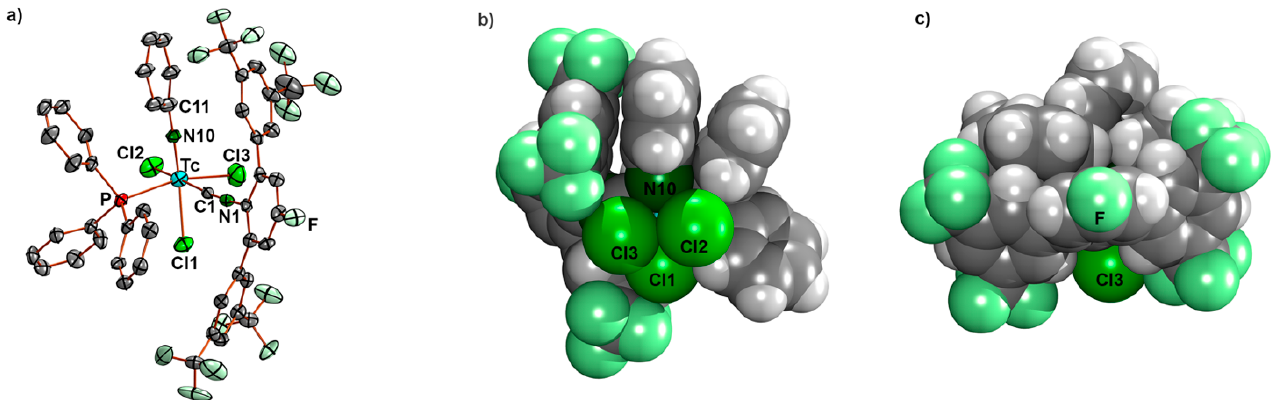
Figure 3. ( a ) Ellipsoid representation of the molecular structure of [Tc(NPh)Cl 3 (PPh 3 )(CN p -FAr DarF2 )] ( 5 ) and illustration of the steric bulk caused by the isocyanide and PPh 3 ligands by ( b ) A view along the phenylimido plane and ( c ) A view along the isocyanide bond. Selected bond lengths and angles: Tc-N10 1.710(4) Å, Tc-Cl1 2.434(2) Å, Tc-Cl2 2.398(2) Å, Tc-Cl3 2.389(2) Å, Tc-C1 2.009(5) Å, C1-N1